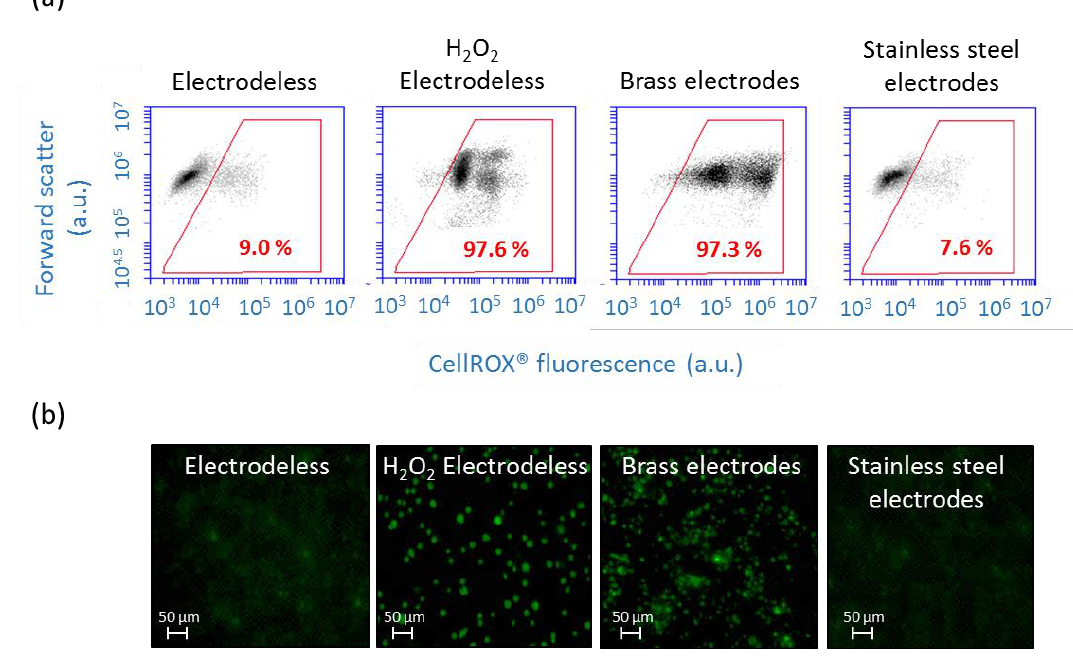
Figure 3. Effect of electrode material on ROS production of C. reinhardtii after 30 min with no AC-field. ( a ) Two dimensional dot plots represent forward scatter (FSC) versus fluorescence green signal of CellROX ® Green obtained by flow cytometry. Percentages in red indicate the proportion of stressed cells stained with CellROX ® Green; ( b ) Micrographs obtained with fluorescence microscopy represent algae observed with the fluorescent FITC filter allowing the detection of CellROX ®